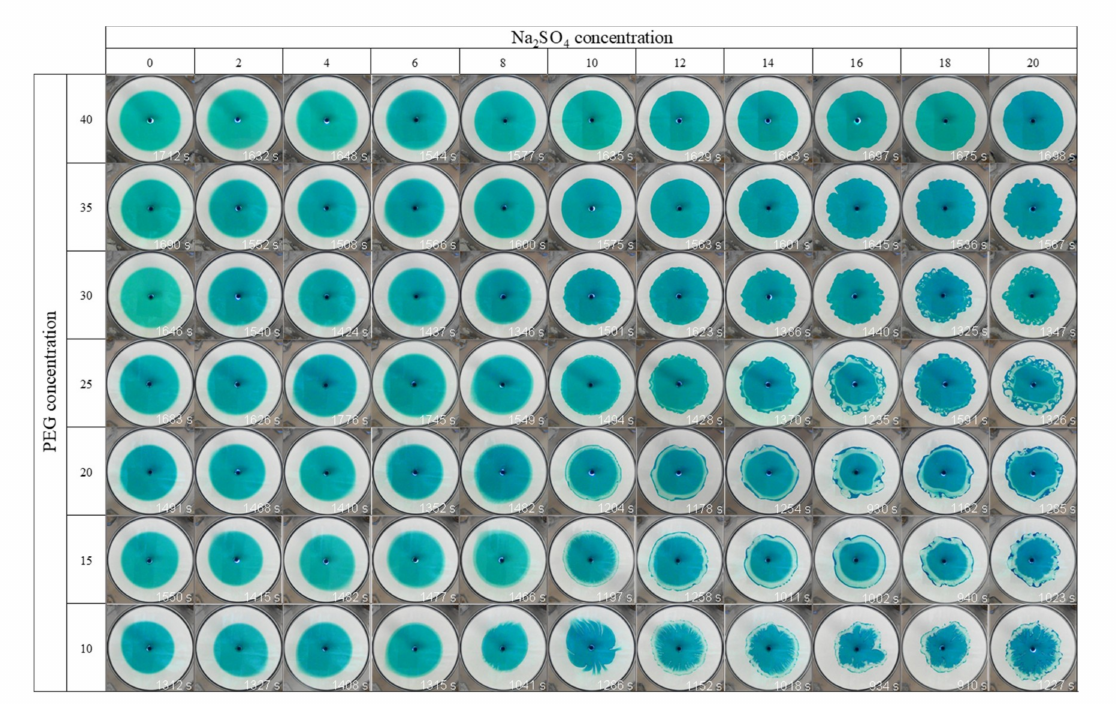
Figure 7. The results of the hydrodynamically stable displacement. The time shown in the right bottom corner is the time when the longest radius reached 42